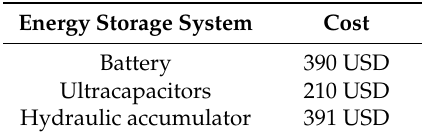
Table 14. Cost of each system.